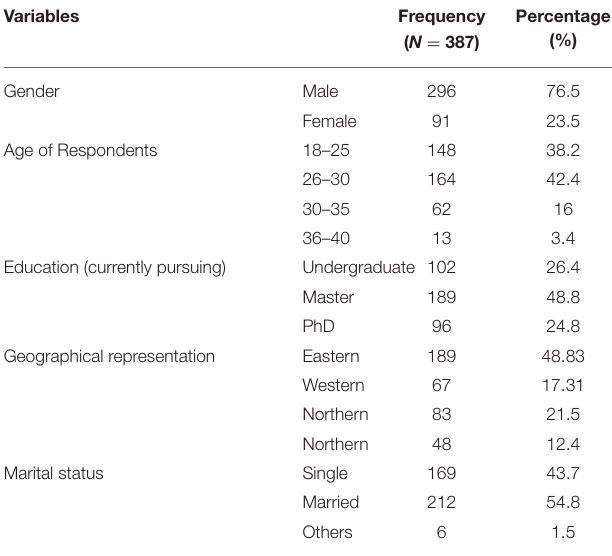
TABLE 1 | Demographic characteristics of